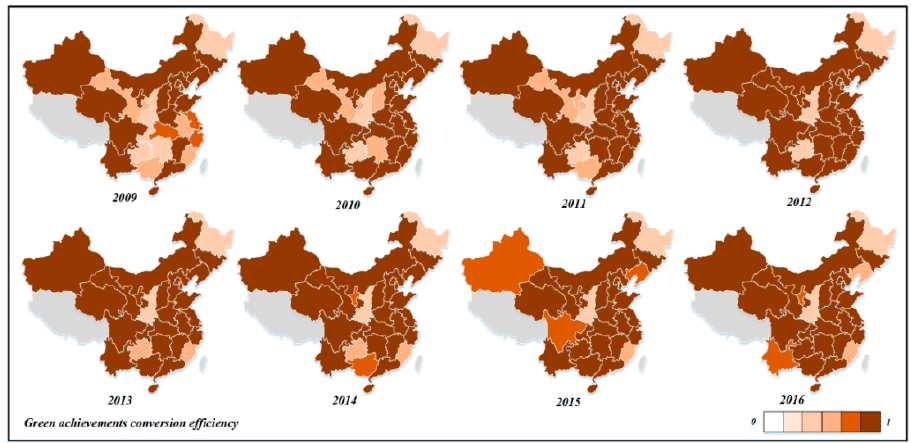
Figure 8. The evolution map of industrial enterprises’ green technology achievements in transformation efficiency in China (2009 – 2016).